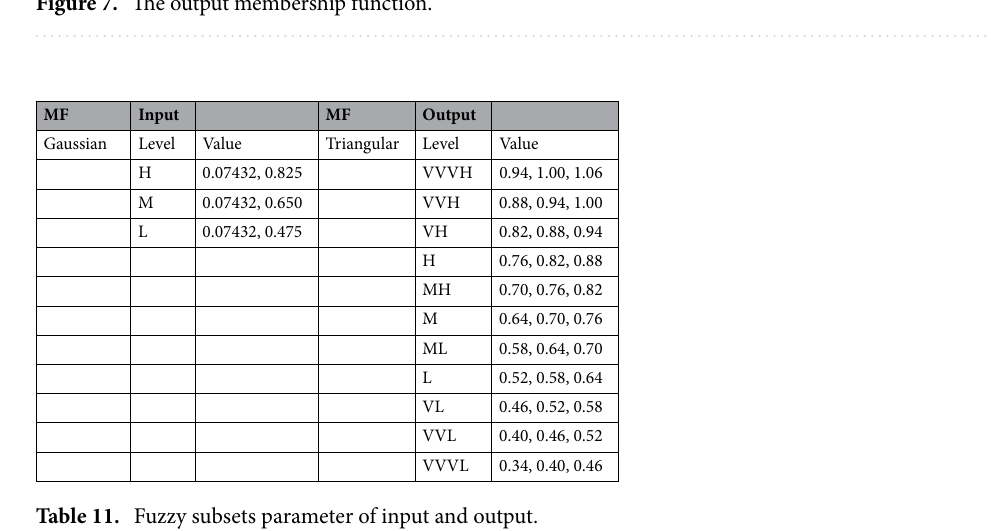
Figure 7. The output membership function.